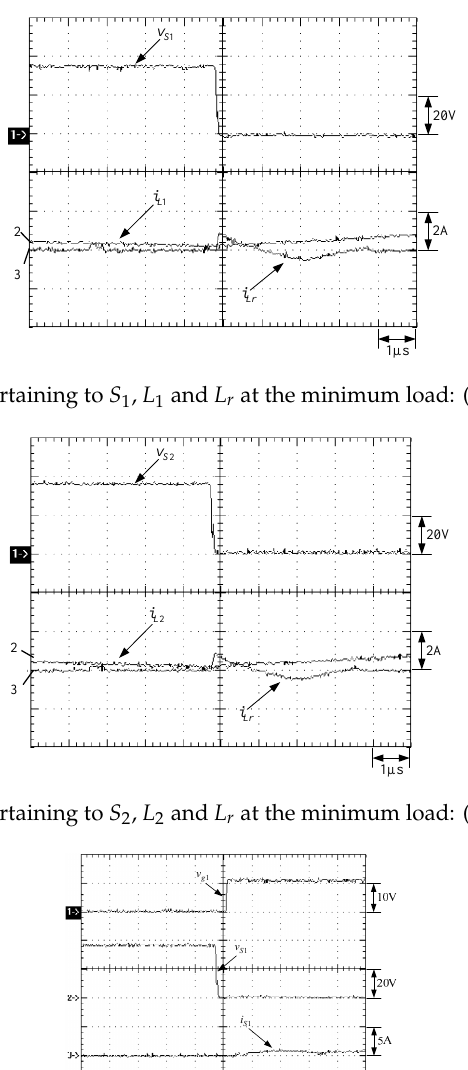
Figure 16. Waveforms pertaining to L r and C r at the minimum load: (1) i Lr ; and (2) v Cr .